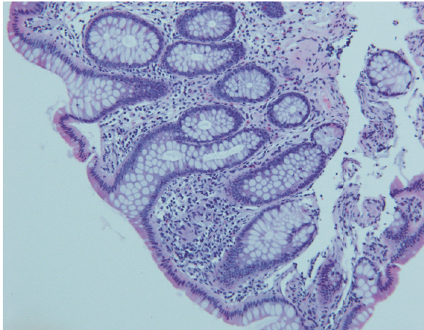
Figure 4: Ascending mucosal biopsy demonstrating resolution of ulceration and